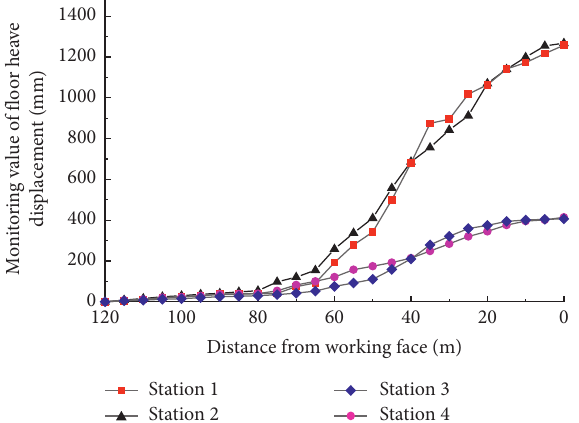
Figure 12: Curve diagram of floor heave displacement at each